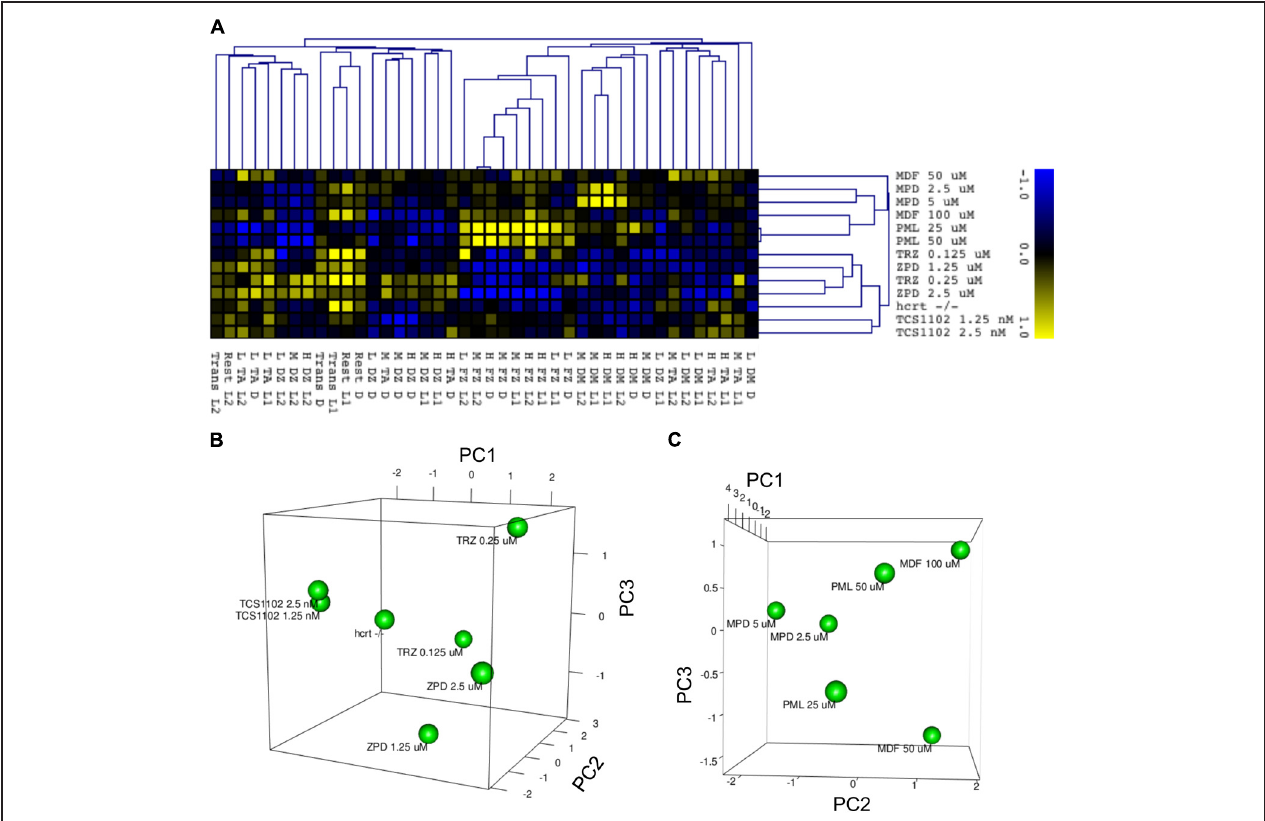
FIGURE 14 | HCL and PCA of behavior of zebrafish treated with sleep/awake modifiers. (A) HCL of behavior of zebrafish treated with sleep/awake modifiers. Z scores of each behavioral endpoint were subjected to HCL using Spearman correlation with average linkage. (B) PCA of behavior of zebrafish treated with hypnotics and hcrt-KO. Z scores of each behavioral endpoint were subjected to PCA. (C) PCA of behavior of zebrafish treated with psychostimulants. Z scores of each behavioral endpoint were subjected to PCA.